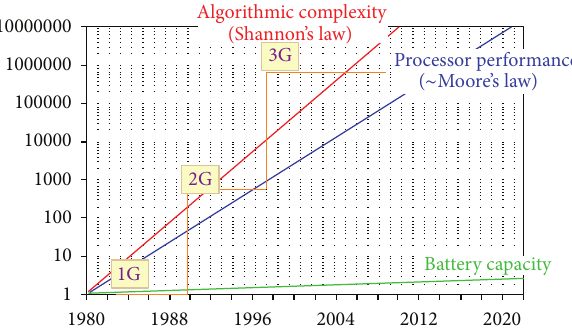
Figure 8: Shannon’s Lay versus Moore’s